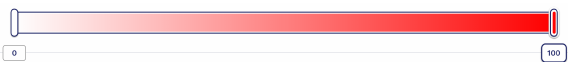
Figure 12. Gradient scale key for model representation from white to